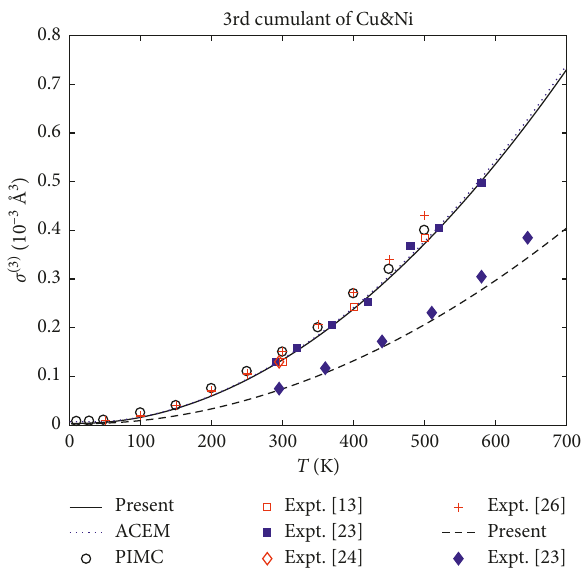
Figure 5: Temperature dependence of third cumulant σ ( 3 ) Cu and Ni calculated using the present theory compared to the experimental values Expt. [13, 23, 24, 26] for Cu and [23] for Ni, as well as to those calculated using the ACEM [9] and the PIMC [19] for Cu.